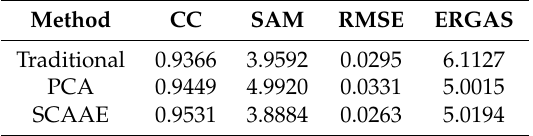
Table 1. Average objective results of different methods on four data